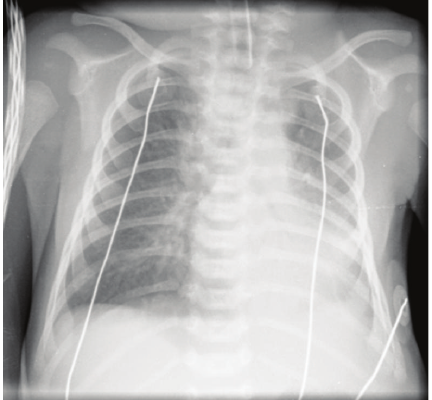
Figure 1: Consolidation pattern-chest radiograph showing pul- monary lower left lobe consolidation.